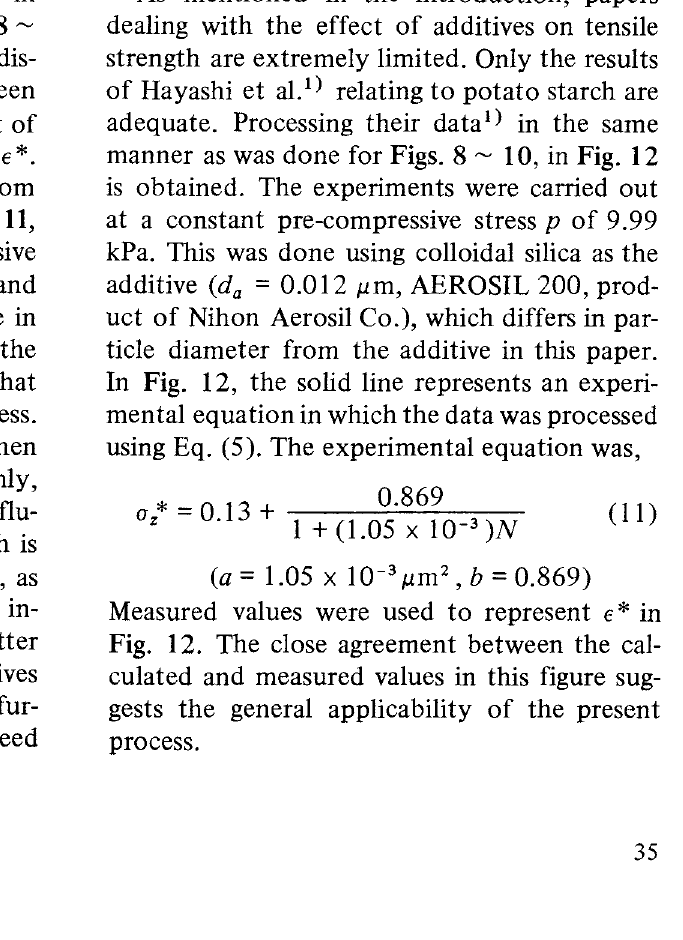
Fig. 10 Relationship between az* and E* (Potato starch) (1: n~O.OOl, ll: 0.001 ~n~O.Ol, ill: 0.01